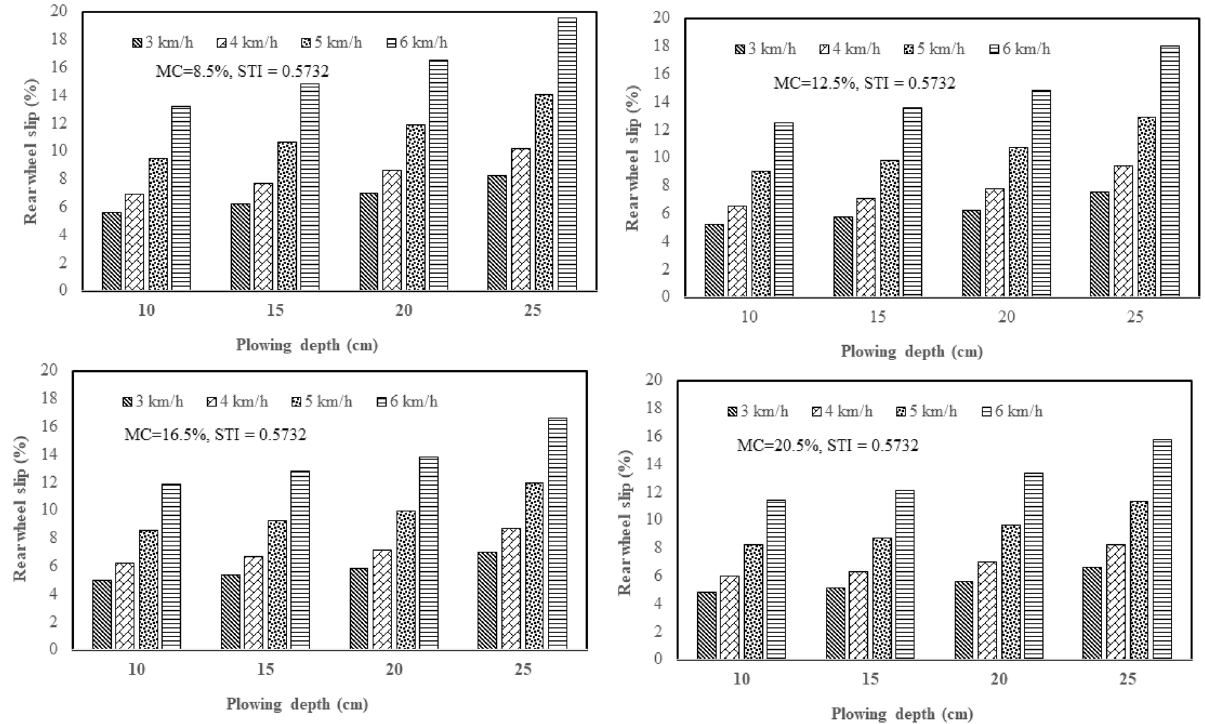
Figure 10. Effect of plowing speed and depth on the tractor rear wheel slip in 2WD mode at different levels of soil moisture content during plowing process by disk plow in soil with a texture index of 0.573. content increased from 7 to 15%, the tractor rear wheel slip decreased from 20 to 16% when the moldboard plow was used. However, in other research studies 2,43 , increasing soil moisture content led to increase tractor rear wheel slip, however, the different results may be due to working characteristics change like tillage speed, tillage depth and soil structure 44 . Wheel slip ANN and regression models analysis. Regression model. An Excel spread sheet was used to obtain the MLR regression coefficients using the same training data used for ANN. The independent parameters included in the MLR model were the moisture content of the soil, plowing speed, plowing depth, soil texture index. The coefficients of determination, number of processing data, prediction accuracy, and multiple linear regression coefficients for each type of plow are shown in Table 3. In addition, Eqs. (12)–(14) show the linear regression equations obtained from the experimental data to get tractor rear wheel slip (RWS, %) for chisel plow, moldboard plow, and disk plow, respectively.